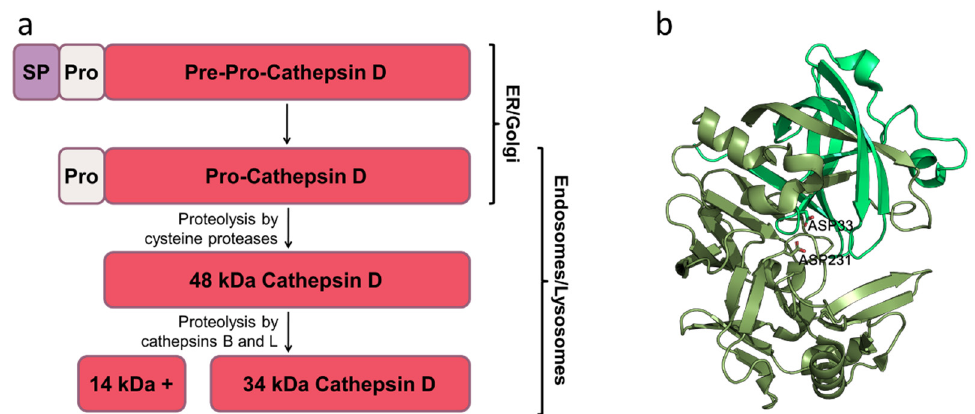
Figure 1. Cathepsin D maturation and structure: ( a ) Major steps of cathepsin D maturation. The description is in the text. SP ‒ signal peptide; Pro ‒ prodomain; kDa ‒ kilodaltons; ER ‒ endoplasmic reticulum. ( b ). Mature cathepsin D structure. The two domains are indicated in different shades of green. Catalytic Asp are represented as sticks. The structure was obtained from Protein Data Bank (PDB ID: 6QCB) [36]. The figure was made in the PyMOL Molecular Graphics System, Version 1.2r3pre, Schrödinger, LLC.